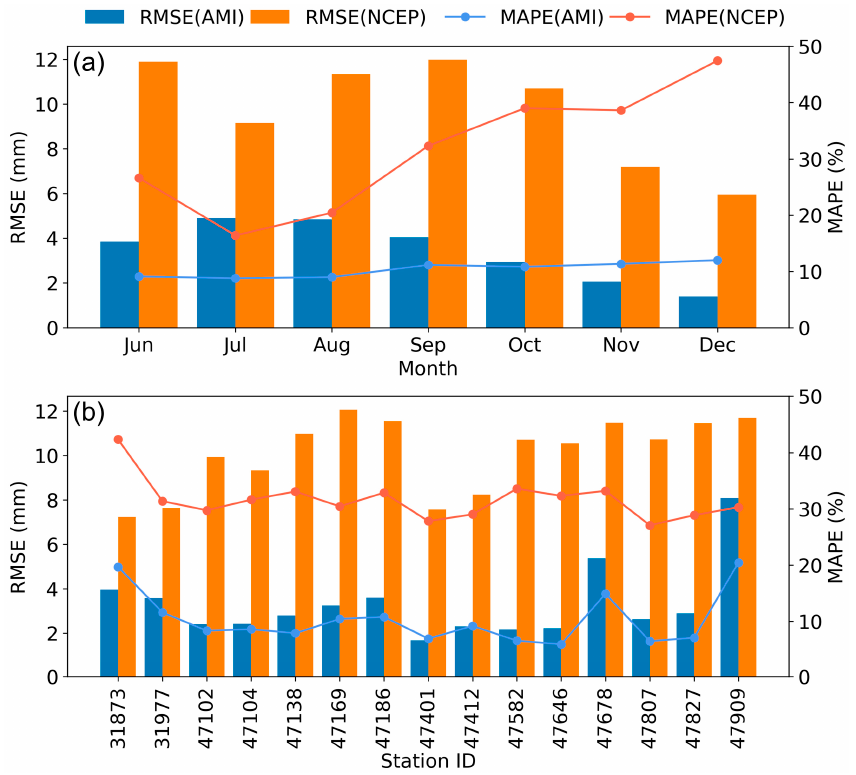
Figure 3. Validation results for AMI and NCEP TPW compared to radiosonde observations according to ( a ) month and ( b ) station identification number. May were excluded due to lack of data.